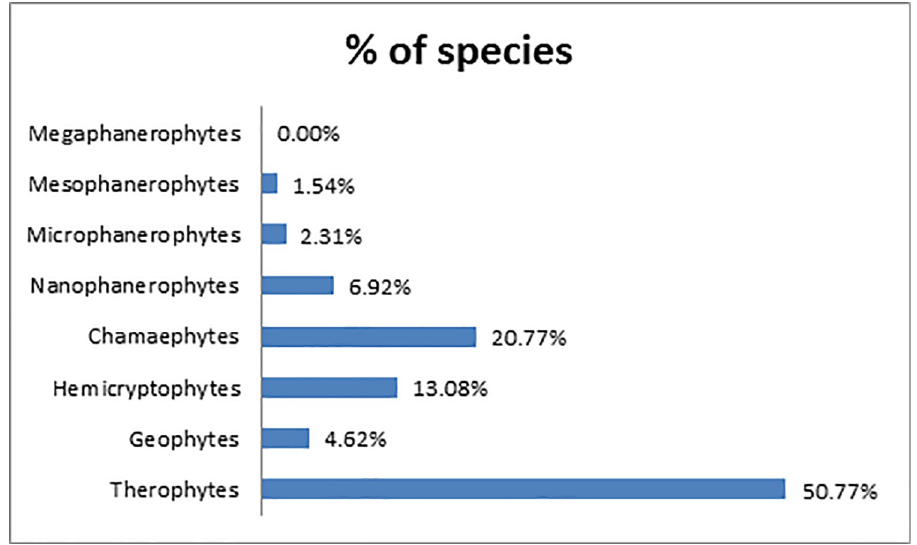
Fig 3. Raunkiaer life-form spectrum of plant species recorded in 78 quadrats in 12 sites in Ras